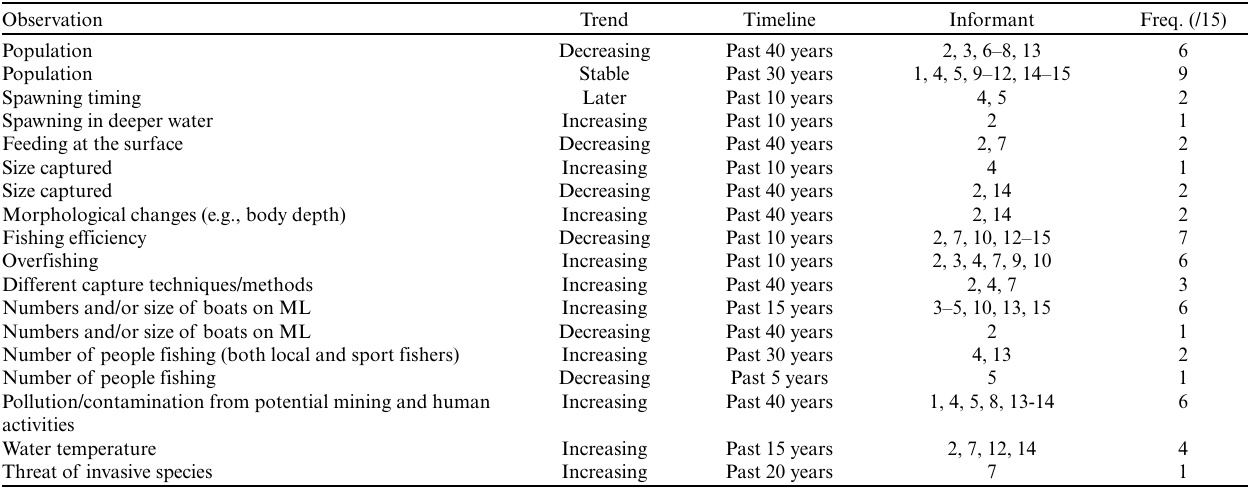
Table 3 . Local Cree concerns related to lake trout conservation and management according to local experts (ML = Mistassini Lake).